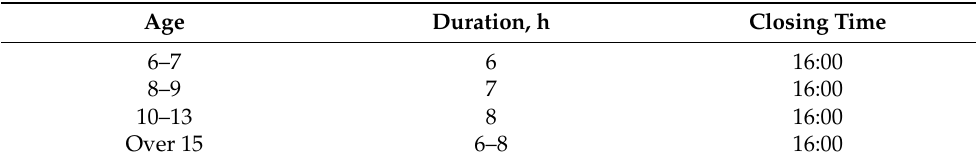
Table A4. School durations by